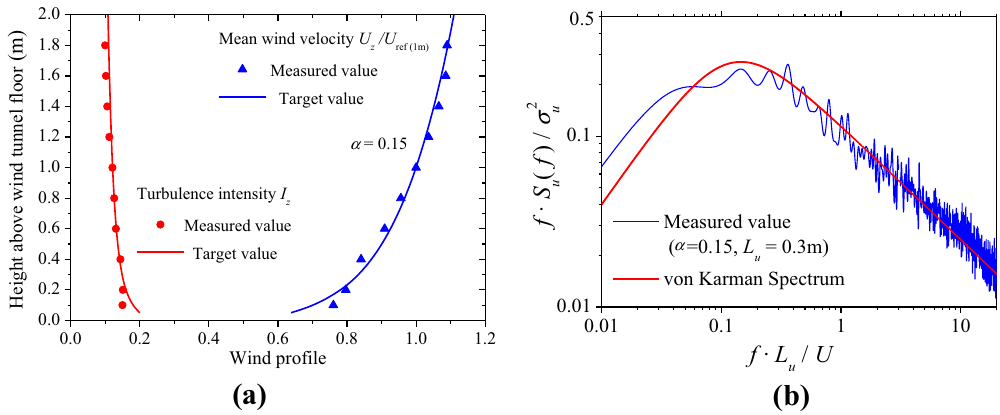
Figure 1. Atmospheric boundary layer simulation results. ( a ) Mean velocity and turbulence intensity profiles; ( b ) Wind velocity power spectrum.